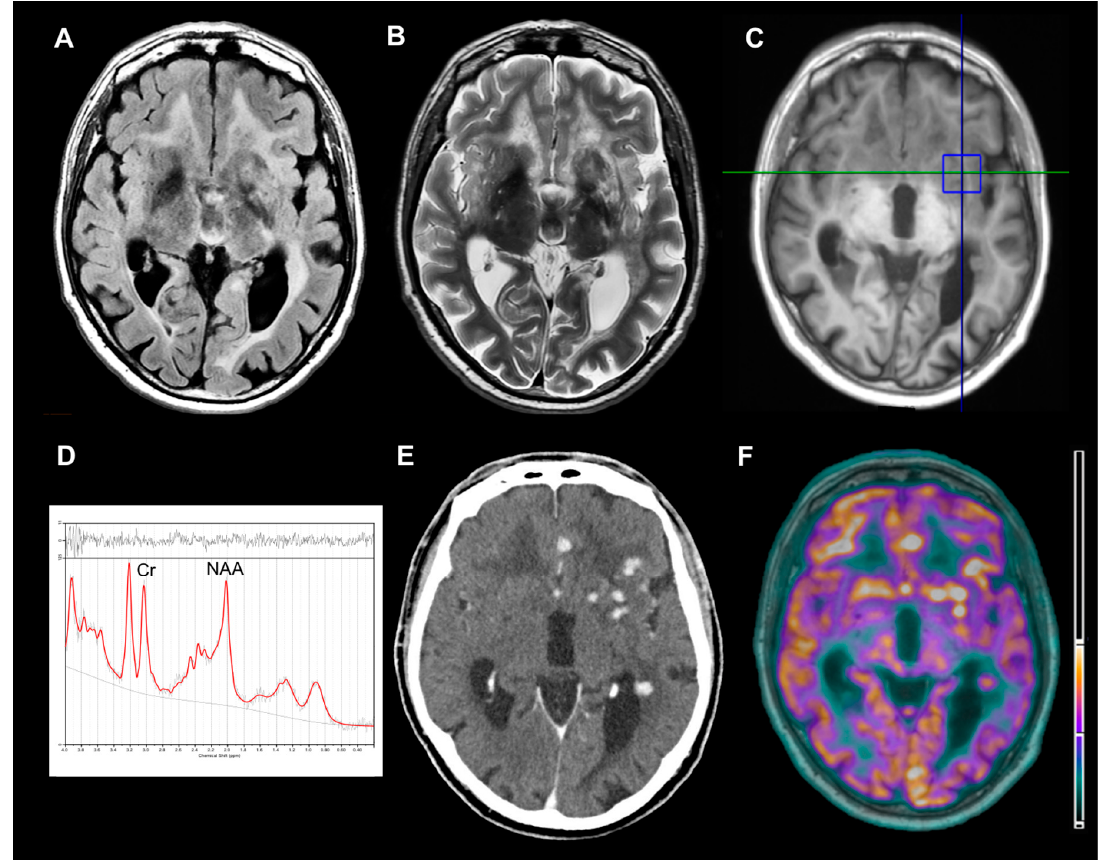
Figure 1. Structural, spectroscopic and metabolic findings of the brain nodular lesions. Axial fluid attenuated inversion recovery (FLAIR)-weighted ( A ) and T2-weighted ( B ) 3T-magnetic resonance imaging (MRI) images demonstrating several parenchymal nodular lesions and leukoencephalopathy. Single-voxel 1 H-magnetic resonance spectroscopy ( 1 H-MRS) involving basal ganglia lesions ( C ) and relative spectrum ( D ) showing N -acetyl-aspartate/creatine (NAA/Cr) reduction, without abnormal lactate or lipids peaks (NAA/Cr ratio was 0.873). Axial contrast-enhanced computed tomography (CT) ( E ) and fluorine-18-fluorodeoxyglucose-positron emission tomography ( 18 F-FDG-PET)/3T-MRI ( F ) images demonstrating iopromide enhancement and hypermetabolism of all nodular lesions (the units are representative of percentage of overlap between MRI and PET).